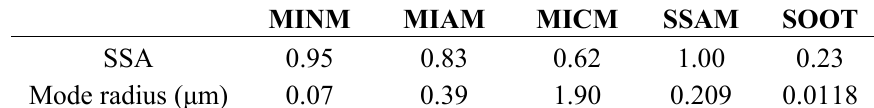
Table 3. Microphysical properties of some OPAC (Optical Properties of Aerosols and Clouds) aerosol components in the dry state. Single scattering albedo (SSA at 500 nm) and mode radius were retrieved from [32,33].